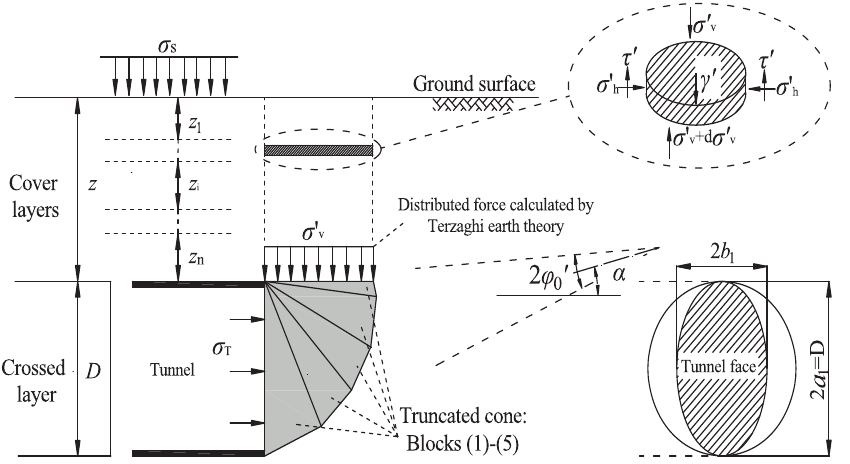
Figure 6. Combined multiblocks failure mechanism, Han et al.